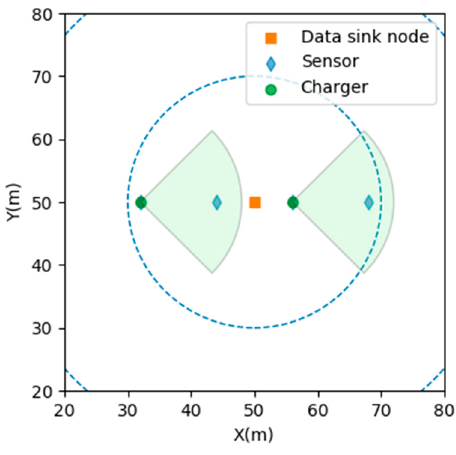
Figure 6. Remove the excess charger position.